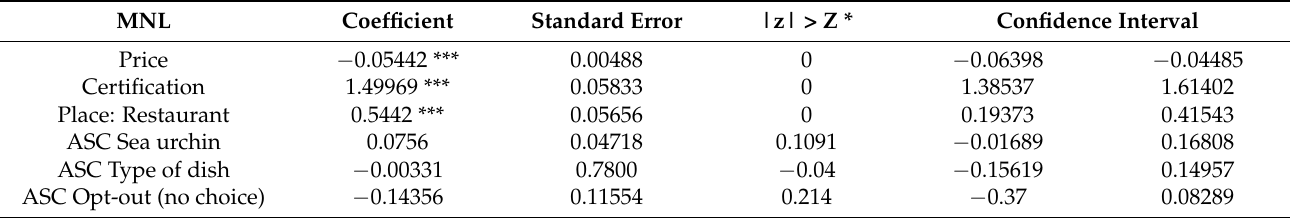
Table 10. Multinomial logit model (MNL)